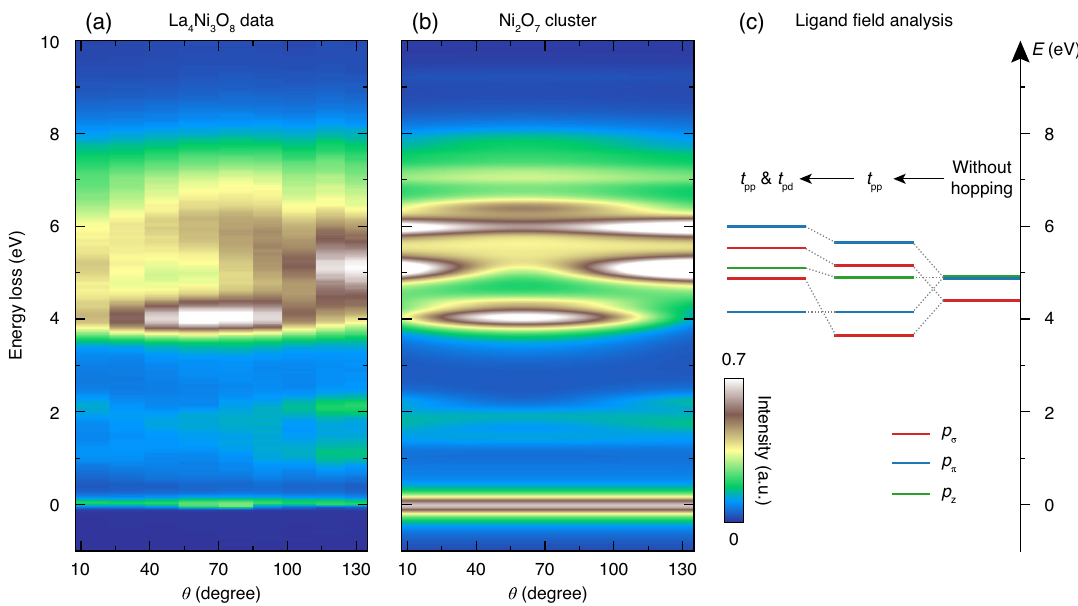
FIG. 4. Angle dependence of La 4 Ni 3 O 8 RIXS intensity at the preedge with σ polarization. (a) RIXS map data after absorption correction. (b) Simulation of a Ni 2 O 7 cluster. (c) Orbital energy-level diagram of the multiplet ligand field analysis using the